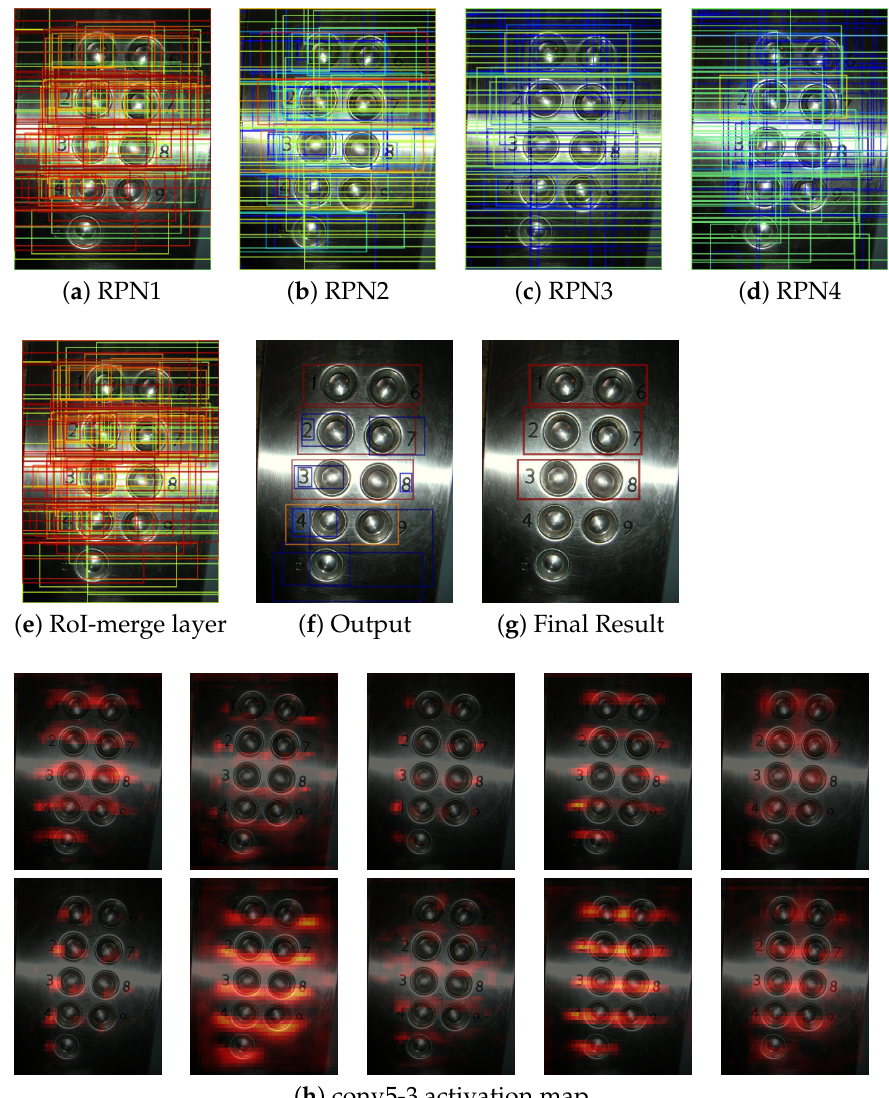
Figure 9. Failure example